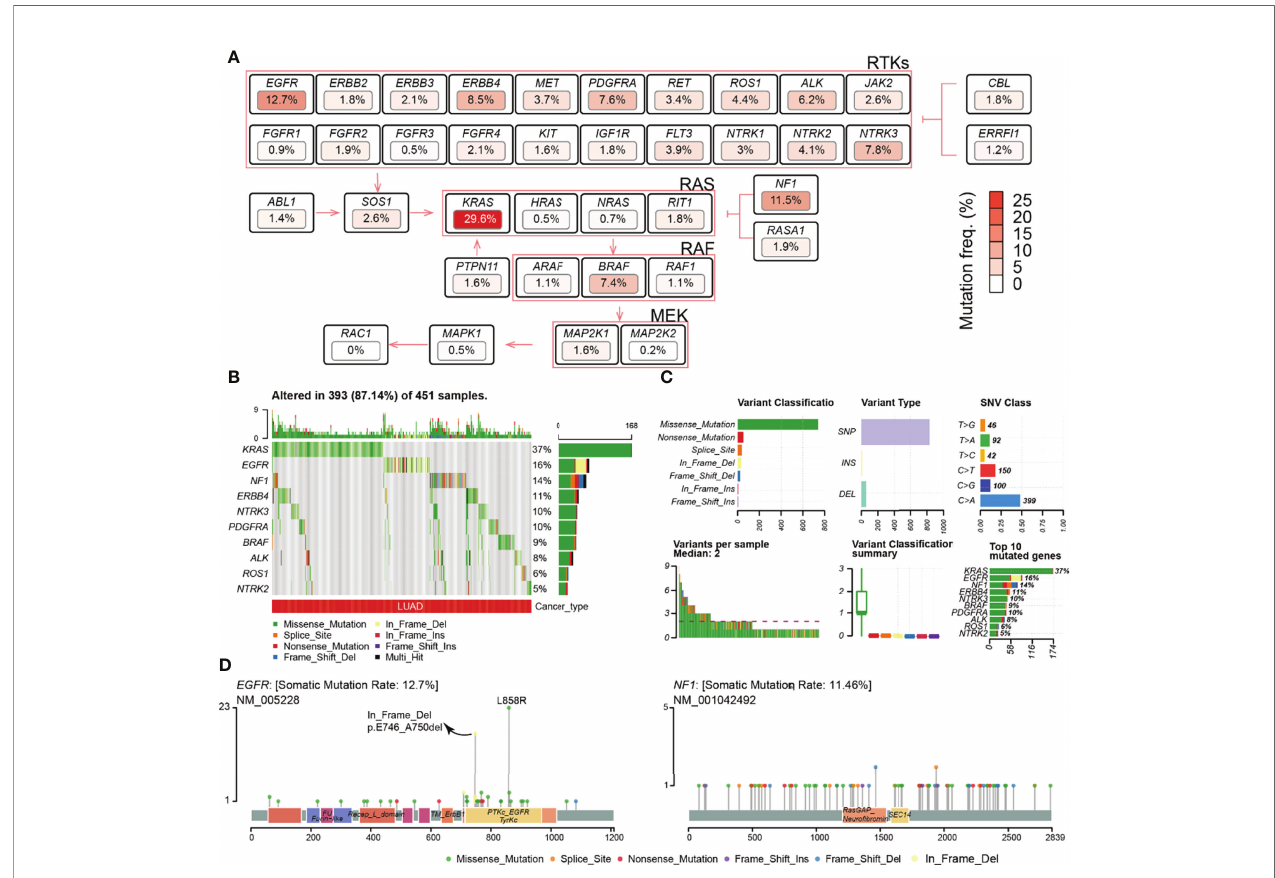
FIGURE 1 | Frequency and class of the SNV of the RTK/RAS pathway. (A) Summary of the SNV frequency of the RTK/RAS pathway and the inner relationship within the signaling path. Color is correlated with the frequency of SNV. (B) Summary of the variant type and classi fi cation of RTK/RAS pathway genes. (C) Distribution of the SNV of top 10 frequently mutated genes in LUAD samples. (D) Lollipop plot showing the location and count of SNV in the coding region of EGFR and